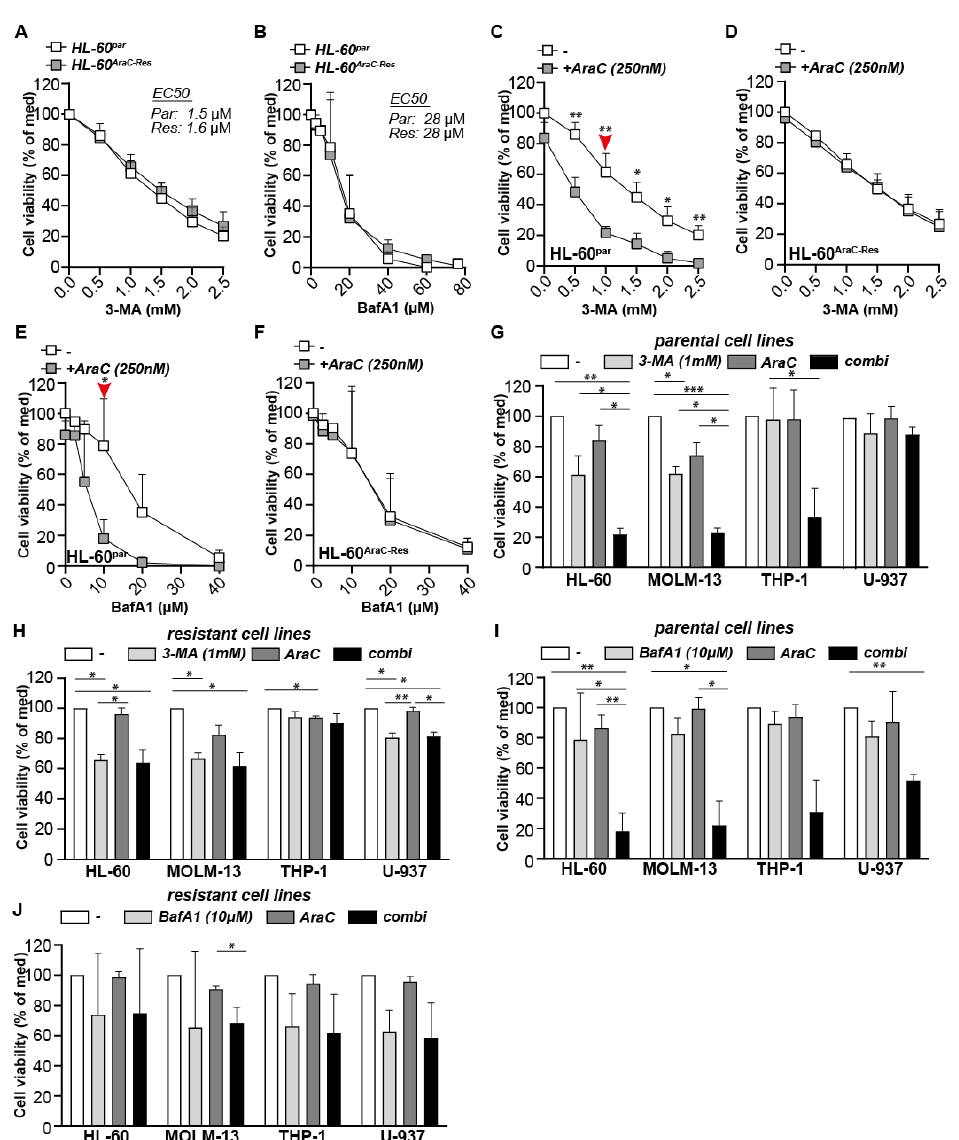
Figure 5. Autophagy inhibitors 3-Methyladenine (3-MA) and Bafilomycin-A1 (BafA1) increase the efficacy of AraC in parental cells, but do not re-sensitize AraC resistant cells for AraC. ( A , B ) Cell viability of HL60 Par and HL60 AraC-Res cells upon treatment with a concentration range of 3-MA and BafA1 (MTS assay after 72 h of incubation, n = 3) ( C – F ). Cell viability (MTS assay) of HL60 Par versus HL60 AraC-Res cells upon treatment with various concentrations of 3-MA or BafA1 in combination with a sublethal dose of AraC (250 nM, 72 h, n = 3). The red arrows indicate the optimal 3-MA and BafA1 concentration to observe additive effects in combination with AraC, which is used in ( G – J ). ( G , H ) All parental cell lines ( G ) and AraC-Res cell lines ( H ) treated with a combination of AraC (sublethal dose) and 3-MA (1 mM) and evaluated for cell viability (72 h incubation) using MTS assays ( n = 3). ( I , J ) All parental cell lines ( I ) and AraC-Res cell lines ( J ) treated with a combination of AraC (sublethal dose) and 3-MA (1 mM) and evaluated for cell viability (72-h incubation) using MTS assays ( n = 3). Significance was tested using students t -test ( A – F ) or one-way ANOVA Tukey’s multiple comparison test ( H – J ). p values are indicated as: *** p < 0.001, ** p < 0.01, and * p < 0.05.